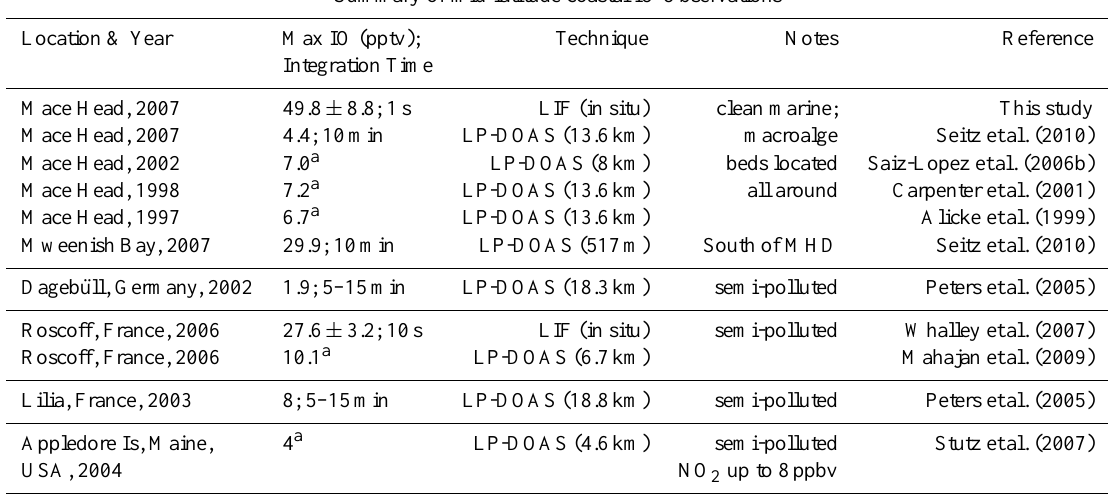
Table 1. Acronyms used are explained in the